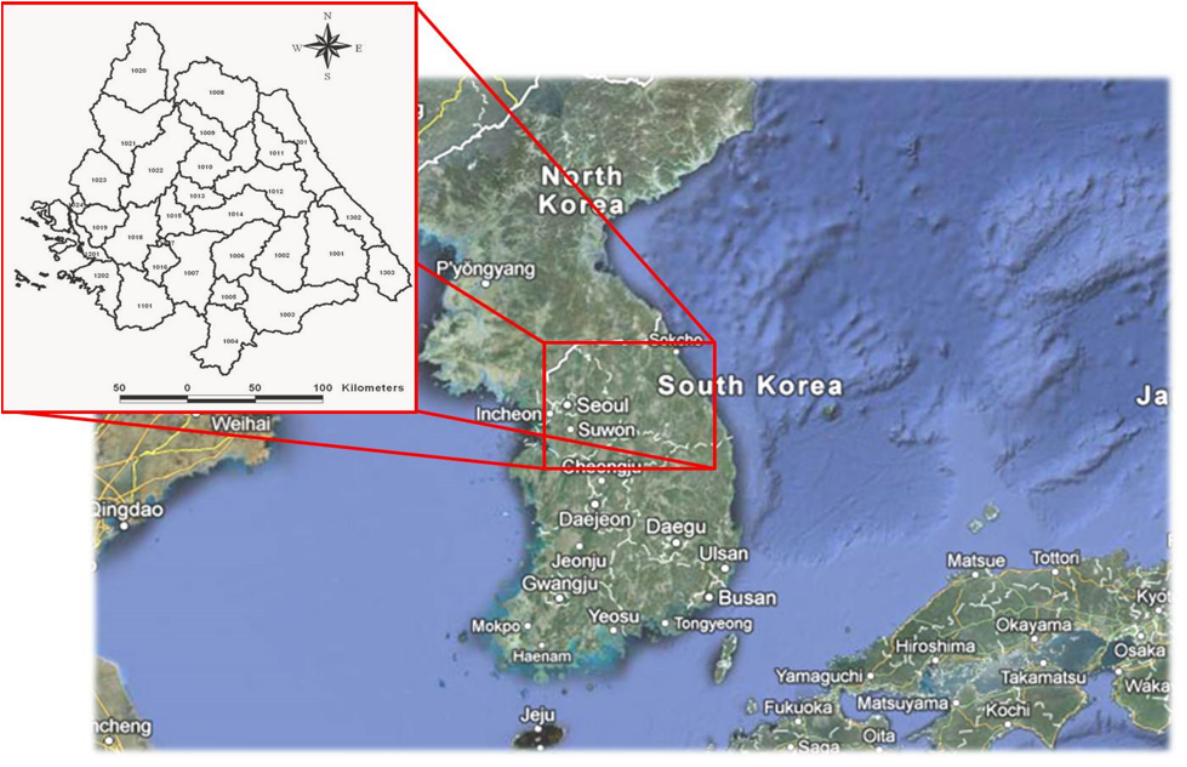
Figure 2. Han River basin,